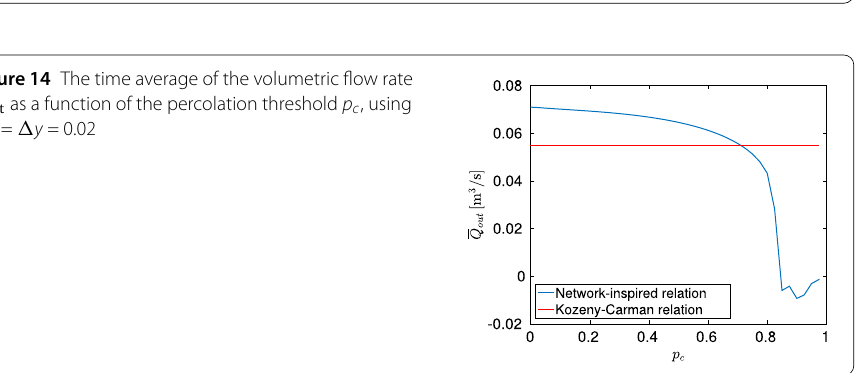
Figure 13 Numerical solutions for the fluid velocity, the permeability and the porosity, at time t = 300, obtained using the network-inspired relation with p c = 0.4935